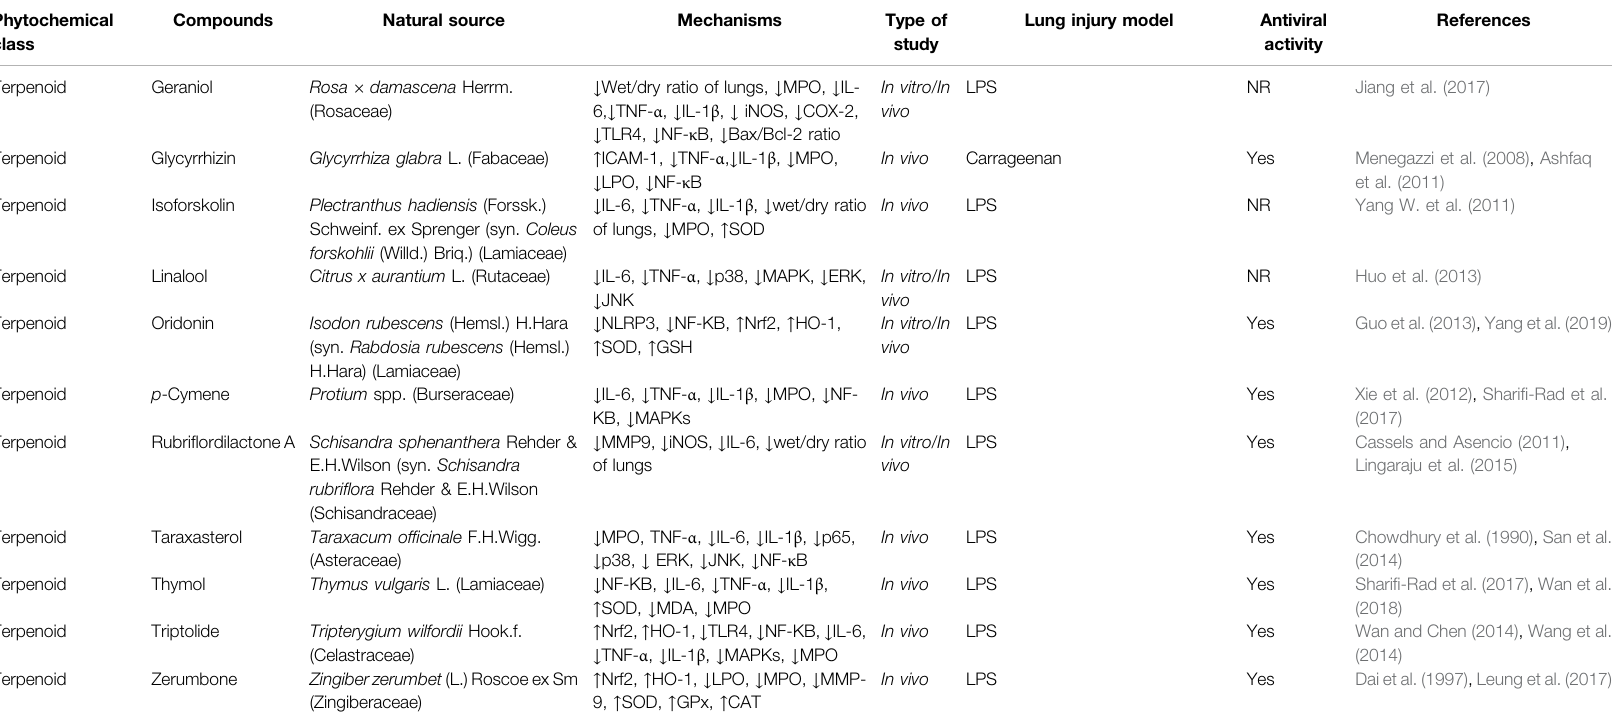
TABLE 1 | ( Continued ) Phytochemicals and their mechanisms of action against lung